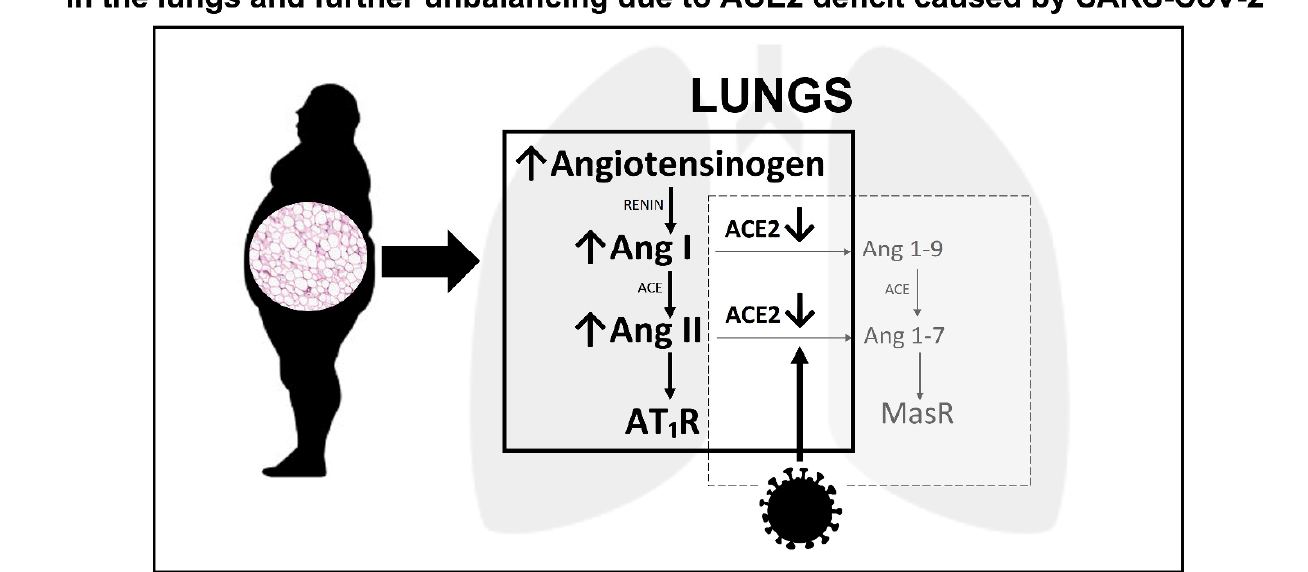
Figure 1. Overweight/obesity, renin-angiotensin-system, and lung injury caused by SARS-CoV-2. ACE, angiotensin-converting-enzyme; Ang, angiotensin; AT1R, angiotensin II type 1 receptor; Mas R, Mas receptor.